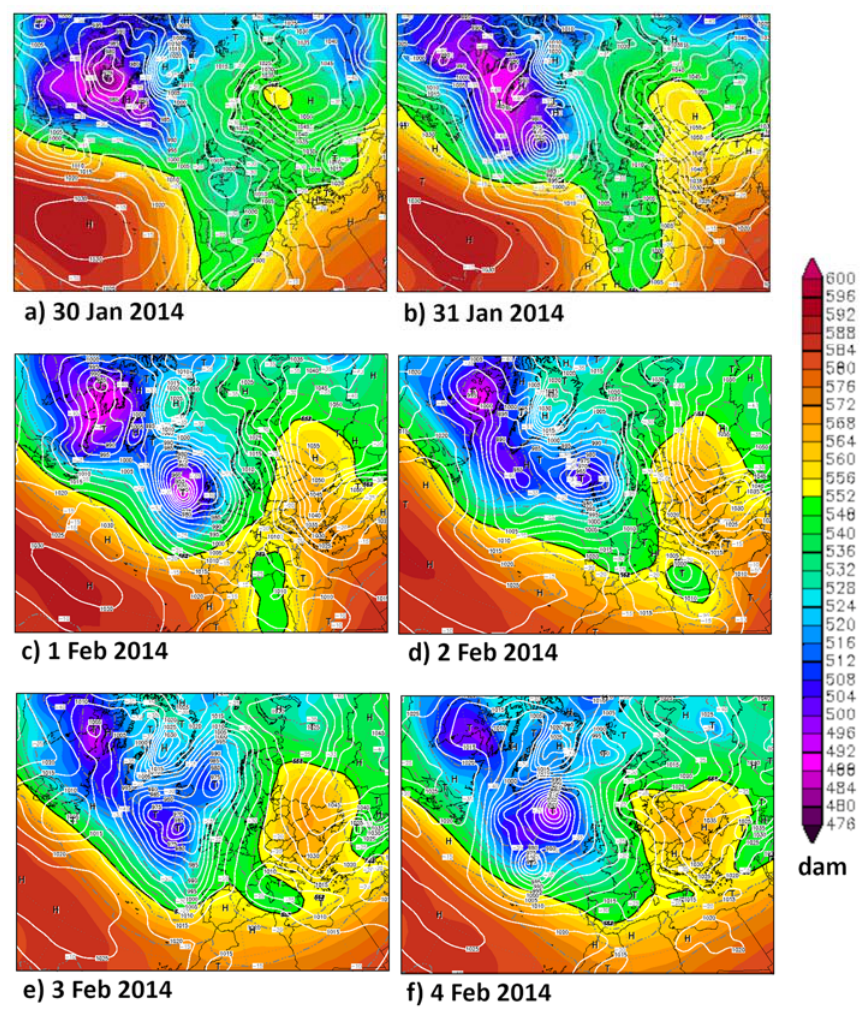
Figure 3. Geopotential height at 500 hPa (shades) and sea level pressure (white isolines) from 30 January to 4 February 2014 over Europe. Source: Global Forecast System Analyses Url: www.wetterzentrale.de (accessed 29 July 2022). For a better visualization of each panel, please refer to the document provided in the Supplementary Material, which contains a wide view of each single panel from page 16 to page 21.